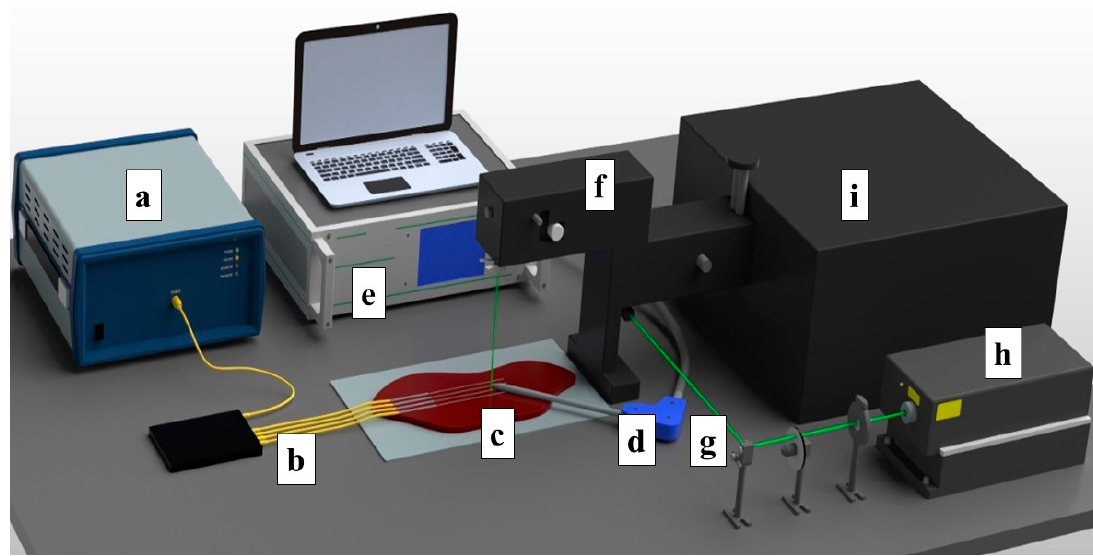
Figure 1. Schematic view of the radiofrequency ablation setup. The setup consisted of: (a) OBR Luna 4600 with a computer used for data acquisition, (b) optical fibers, (c) a bovine liver, (d) the RFA applicator, (e) a hybrid RF/MWA generator used in the RF mode, (f) a confocal microscope, (g) a laser path, (h) a Verdi-G2 532 nm laser source, and (i) a tandem Fabry–Perot interferometer TFP-2.